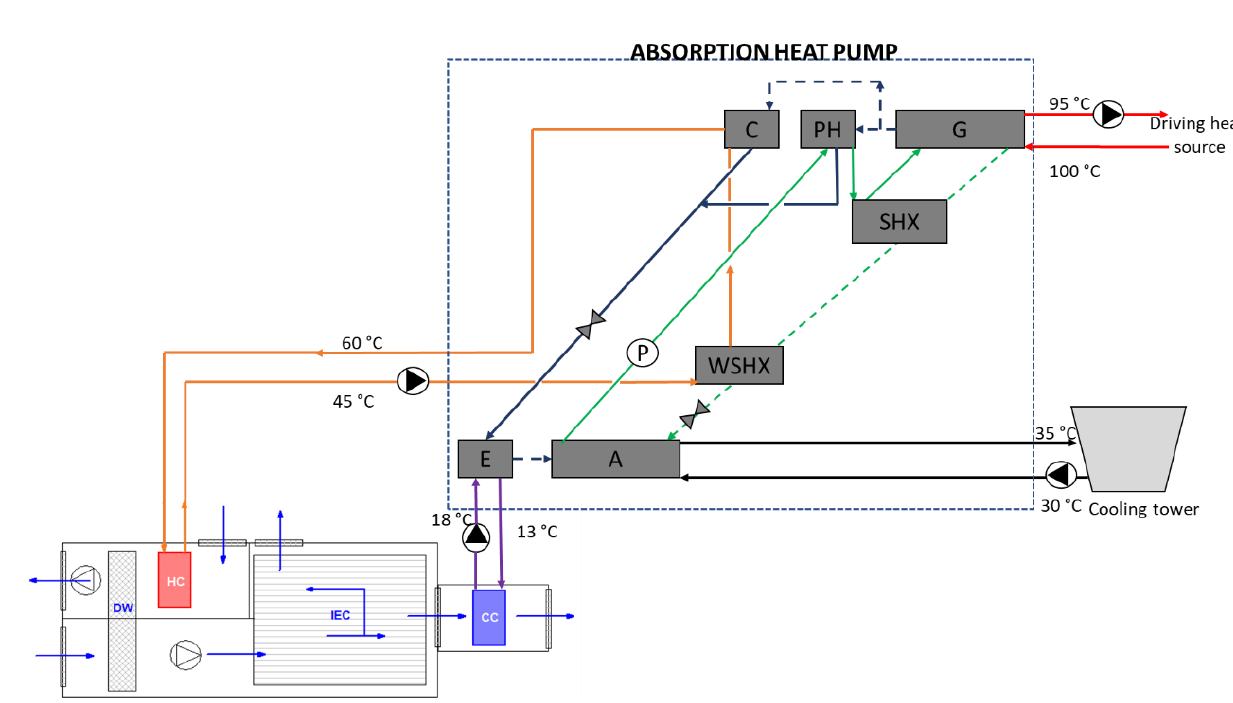
Figure 9. Layout for hybrid air conditioning system with an absorption heat pump and a desiccant evaporative cooling system.